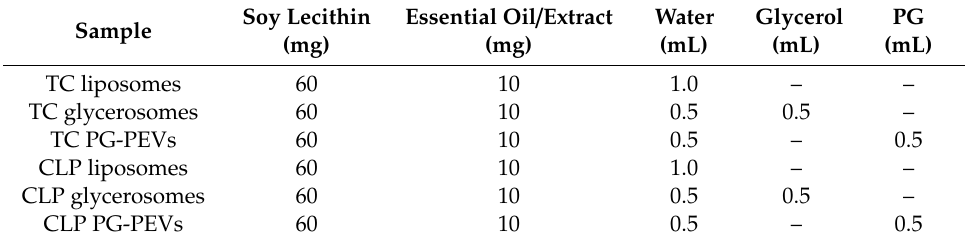
Table 1. Composition of TC essential oil and CLP extract loaded liposomes, glycerosomes, and